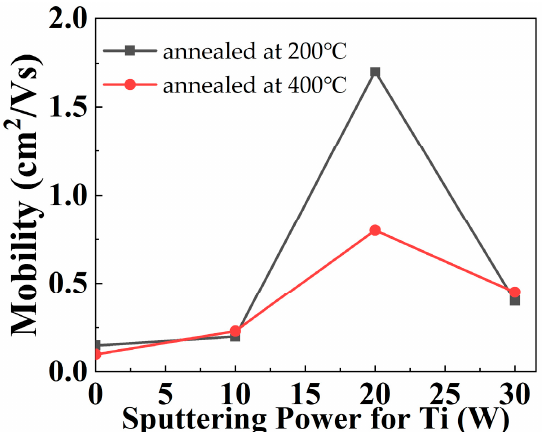
Figure 7. Output characteristics of the OTFTs with increasing Ti content in gate dielectric: ( a ) sample A, ( b ) sample B, ( c ) sample C, and ( d ) sample D.